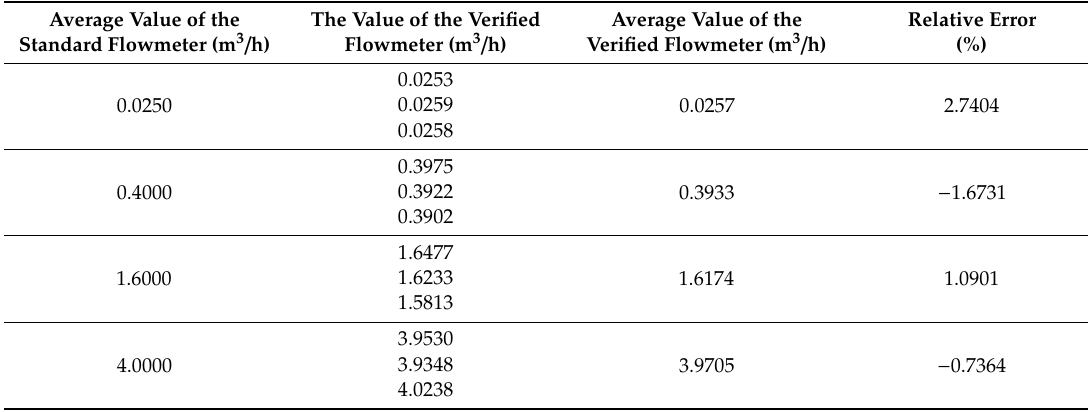
Table 1. Flow experiment data at di ff erent flow